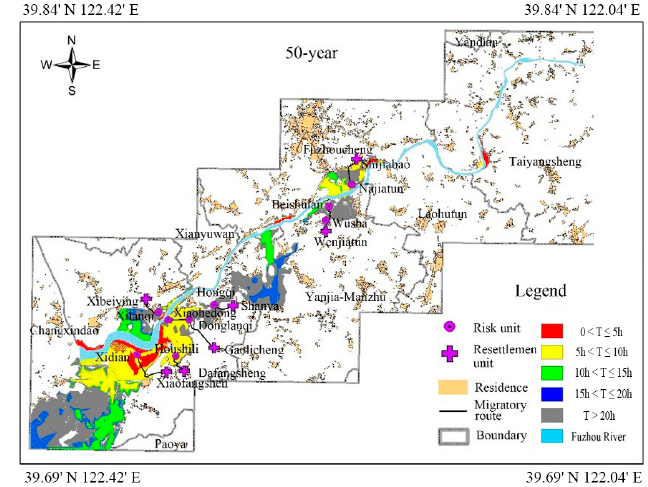
Figure 17. Evacuation plan of 50-year return period scenario.